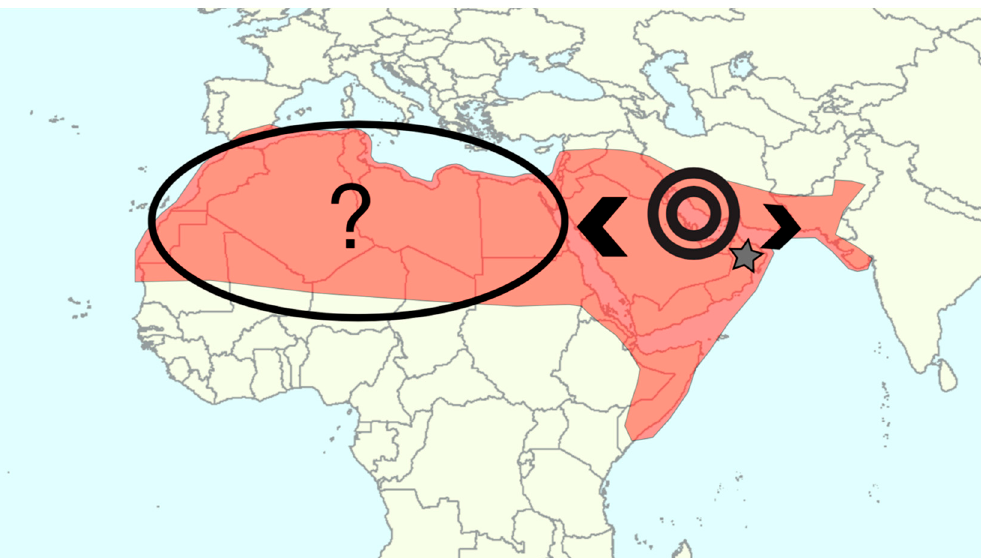
Figure 3. Domestication scenario for the date palm (historical distribution in red) based on the latest lines of evidence in archaeology and genetics. Domestication occurred in the Gulf region (black circles), probably during the 4th millennium BCE from wild populations of P. dactylifera of which relict populations were found in Oman (grey star). It was followed by diffusion toward the East and the West (black arrows). African date palms nevertheless appear very distinct and more diverse than Middle Eastern cultivars, involving that an unknown source contributed to this population. The source population, the exact timing and the geographic context of this event remain to be elucidated.